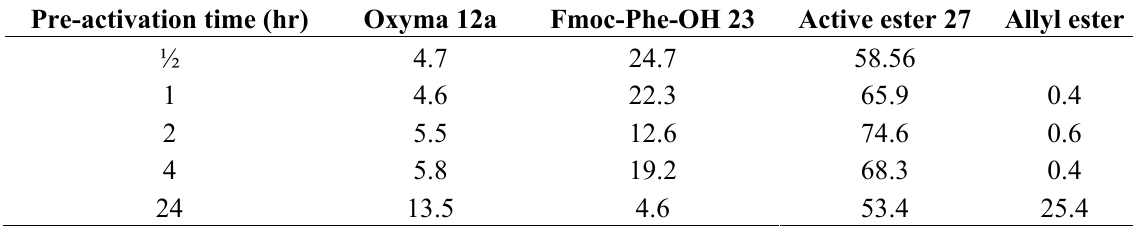
Table 9. The rate of formation of the active ester of Fmoc-Phe-OH 23 using ethyl 2-(allyloxycarbonyloxyimino)-2-cyanoacetate ( 18 ). Pre-activation time